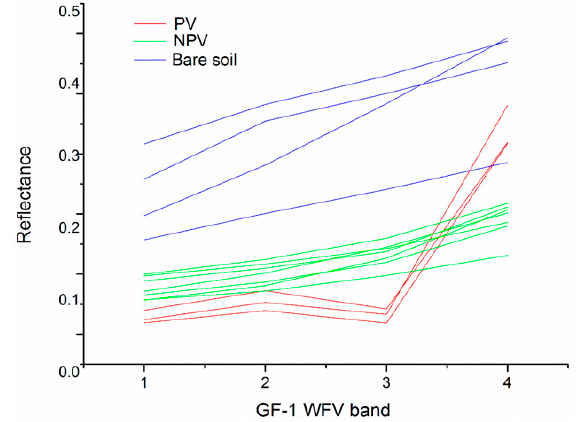
Figure 7. Photosynthetic vegetation (PV), Non-photosynthetic vegetation (NPV) and bare soil endmember variability in Multi-Endmember Spectral Mixture Analysis (MESMA).